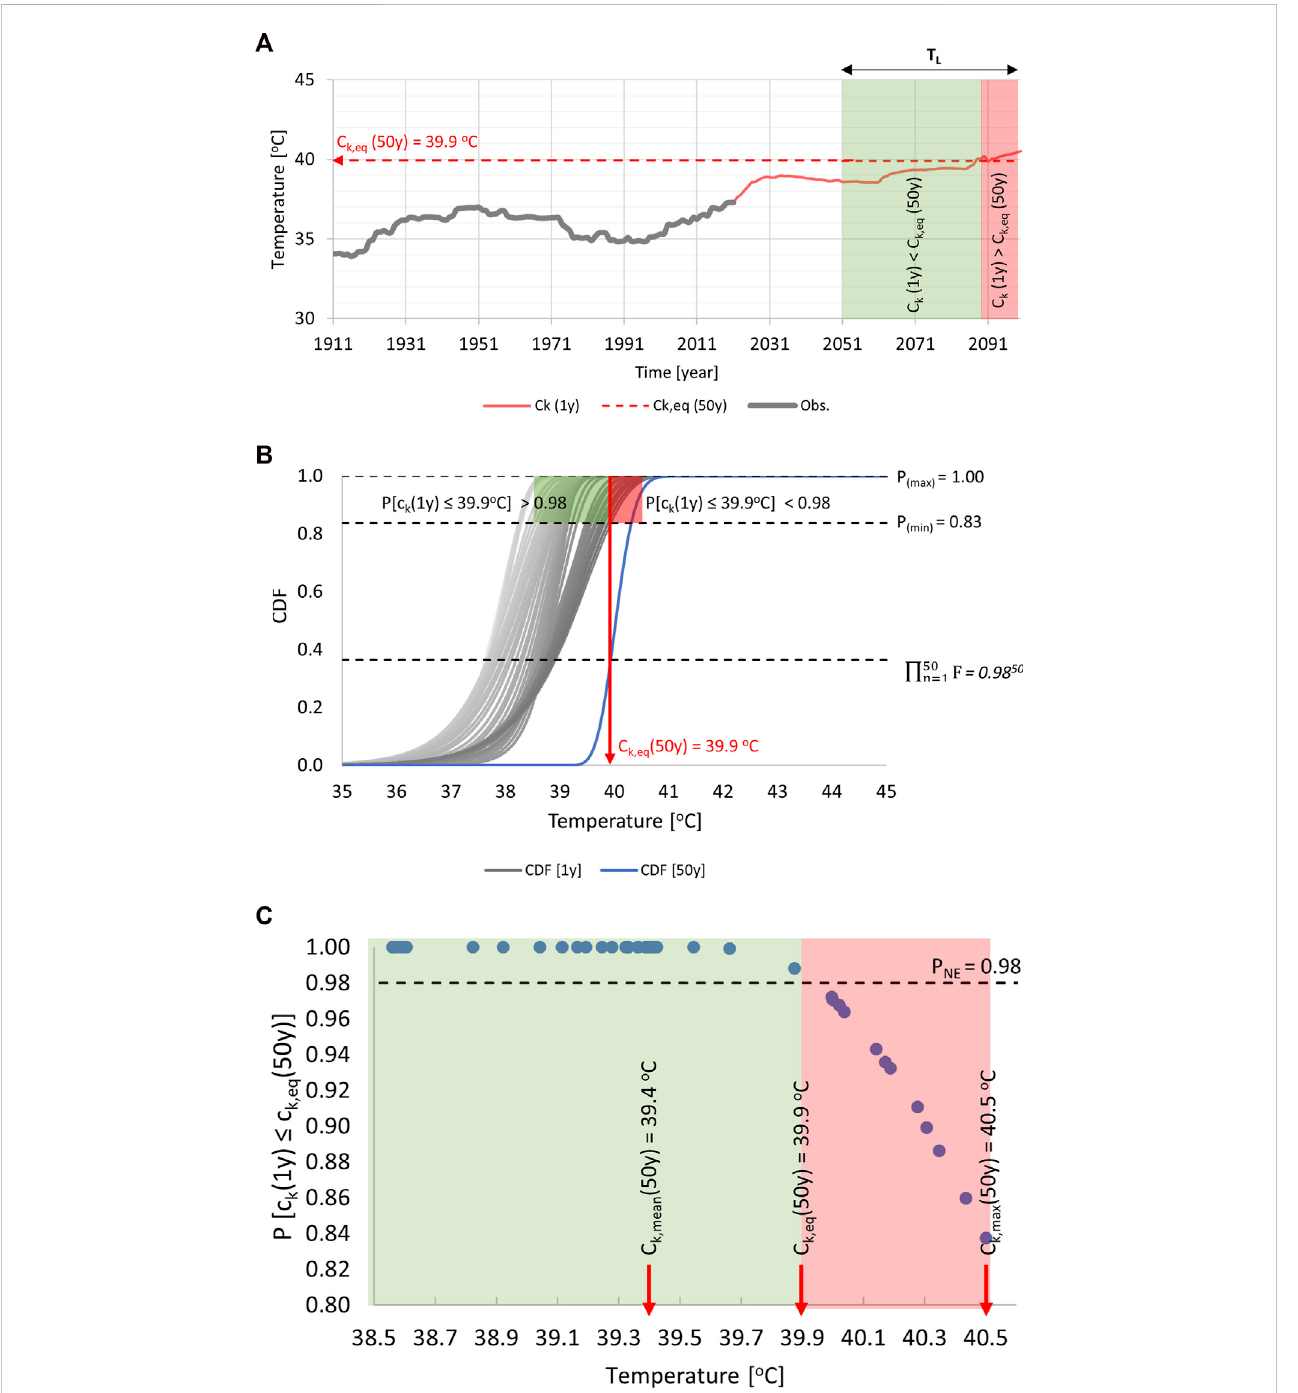
FIGURE 5 Reliability of the non-stationary characteristic values during the design working life of a structure: (A) comparison of the non-stationary characteristic values c k (n) with the 50-year design working life characteristic values c k,eq ; (B) evaluation of 50 distribution functions over the design working life of the structure for non-stationary analysis; (C) comparison of the non-exceedance probabilities reached by c k,eq with the target exceedance probability of